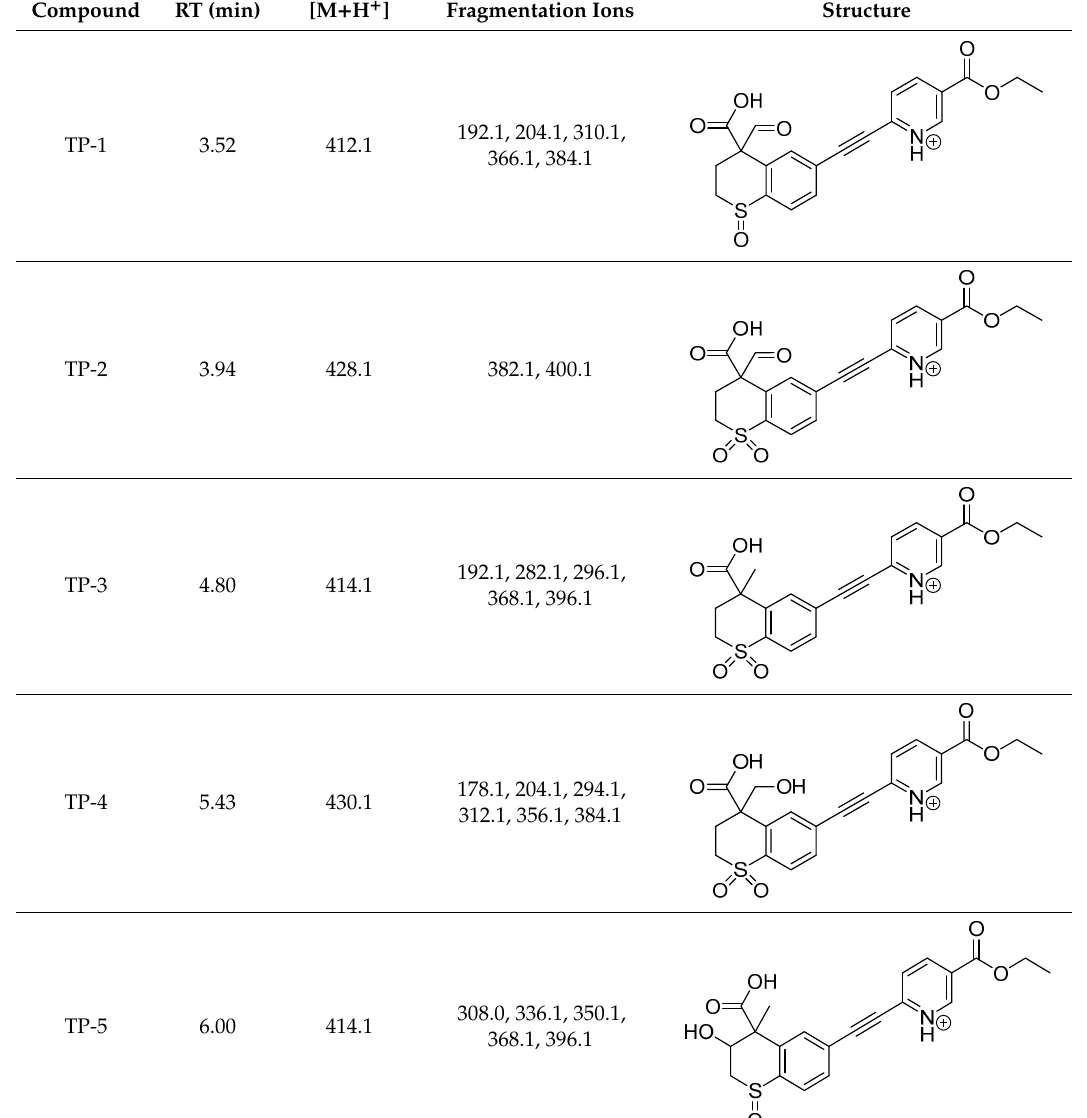
Table 1. Proposed structures of the degradation products of tazarotene.